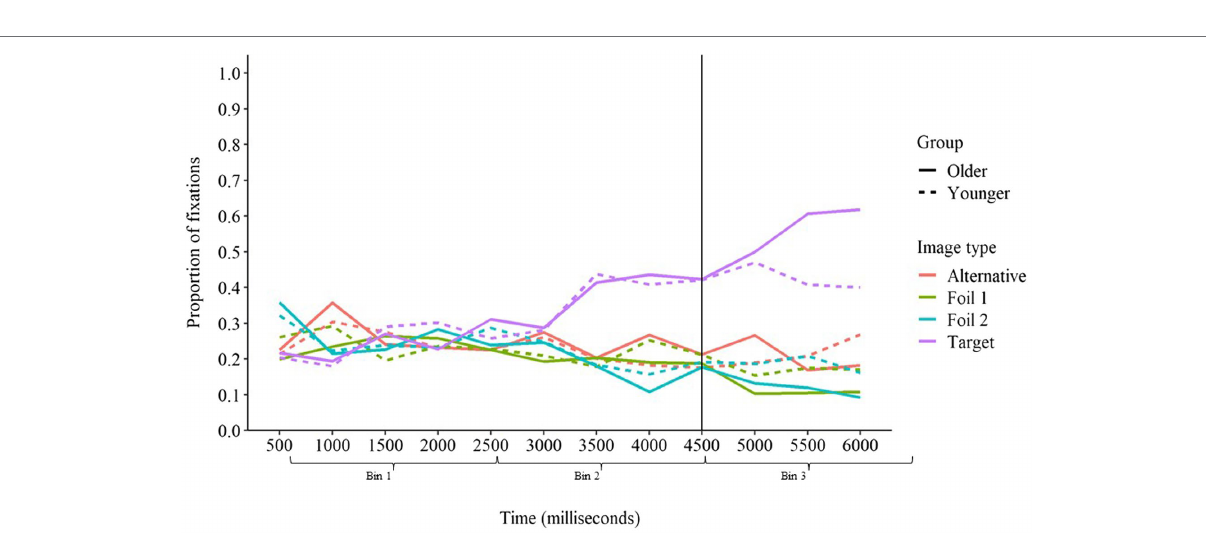
FIGURE 4 | Proportion of fixation on each image type over time in baseline sentences for younger and older adults. The vertical line at 4,500 ms represents the onset of the target word.